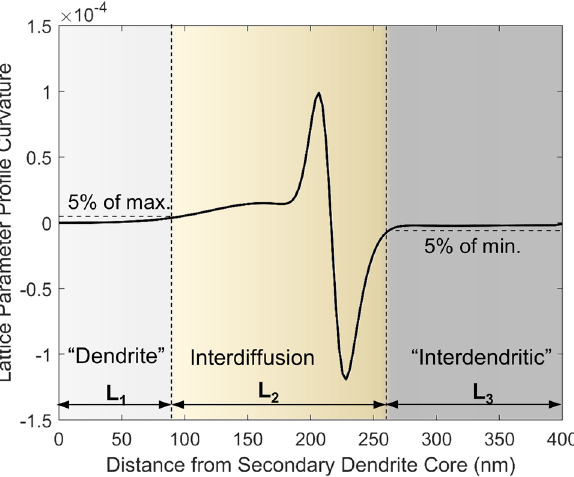
Figure 7. Curvature of the lattice parameter profile calculated from the DICTRA result at the end of Stage III defined by the second derivative. The definitions of the boundaries between L1, L2, and L3 are